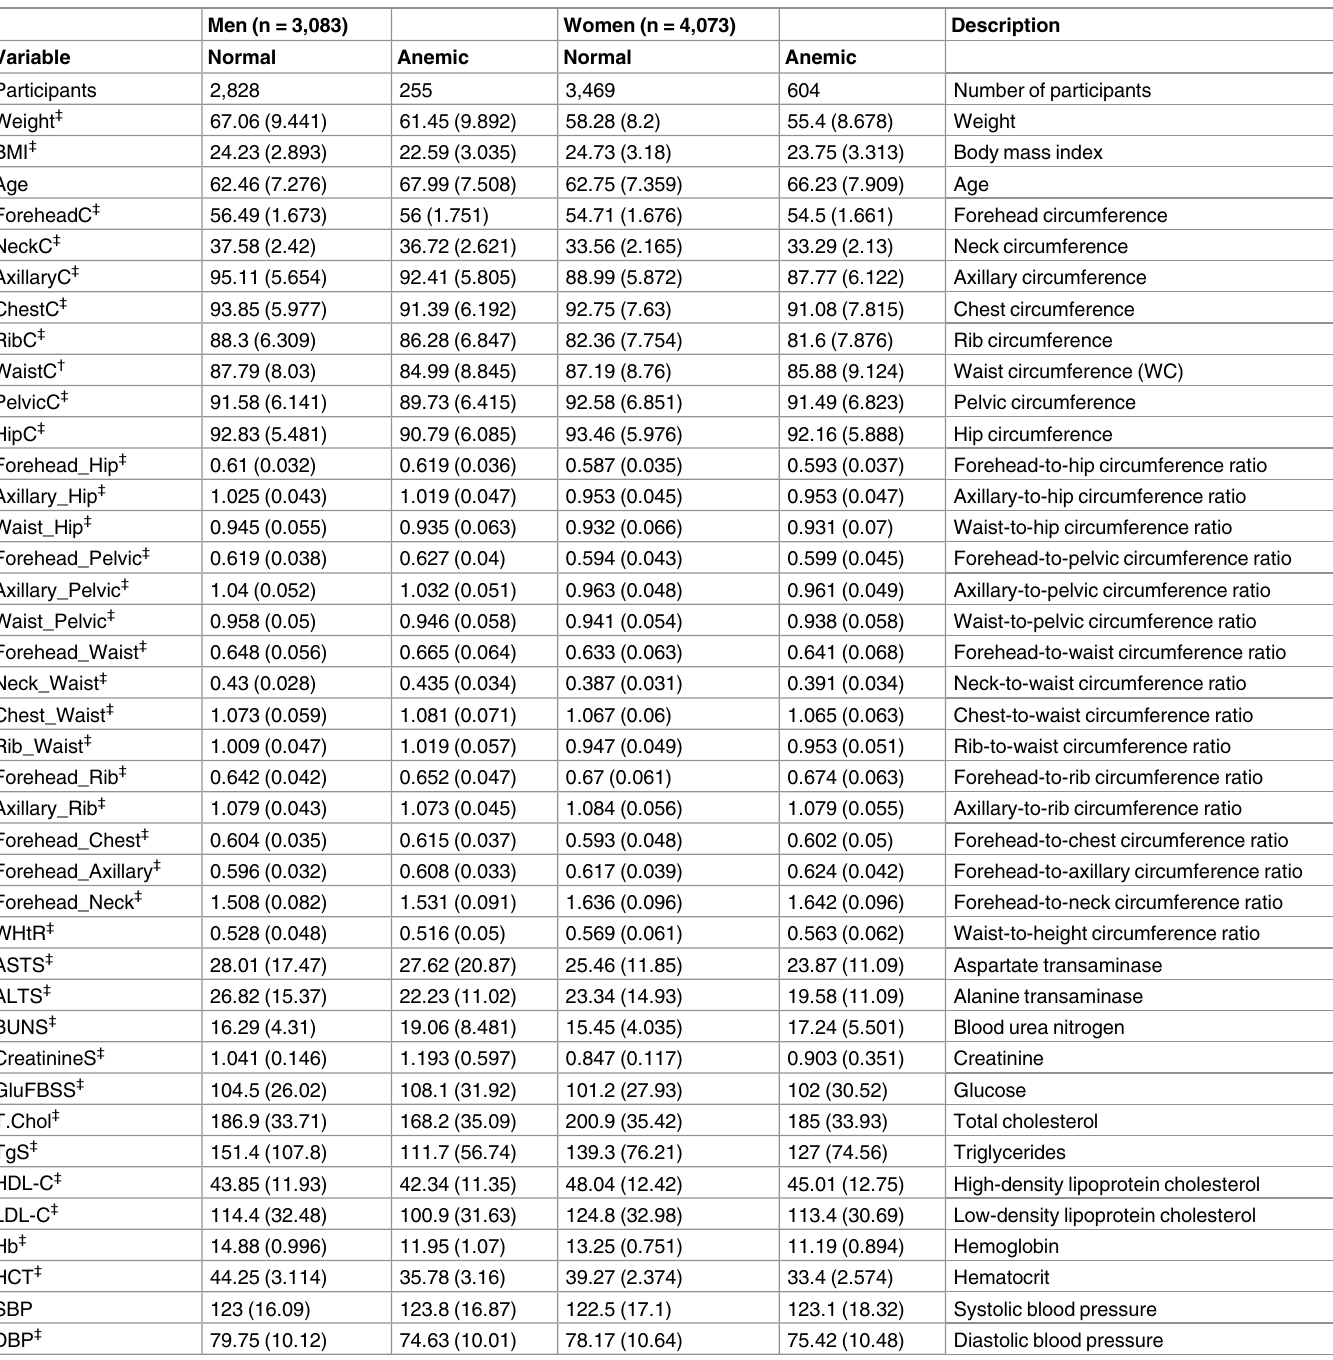
Table 1. Baseline characteristics and brief descriptions of all study